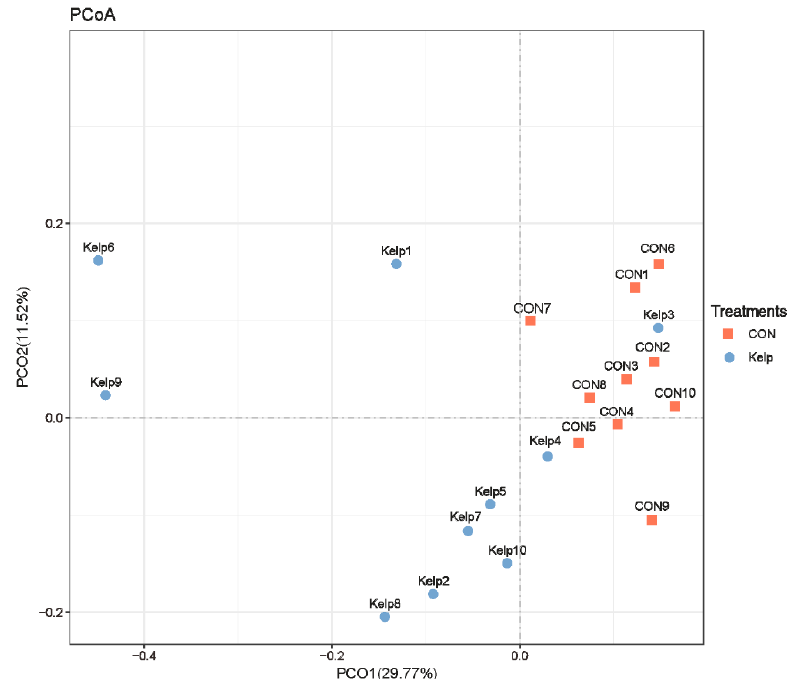
Figure 1. Principal coordinate analysis (PCoA) of bacteria community structures in CON and kelp treatment. CON = control diet; Kelp = kelp powder replacing diet.